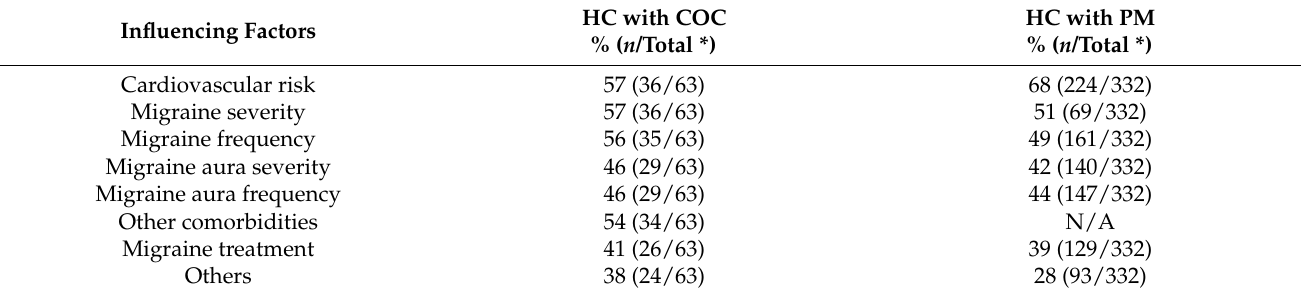
Table 3. Factors limiting HC prescription in concomitant migraine with aura.